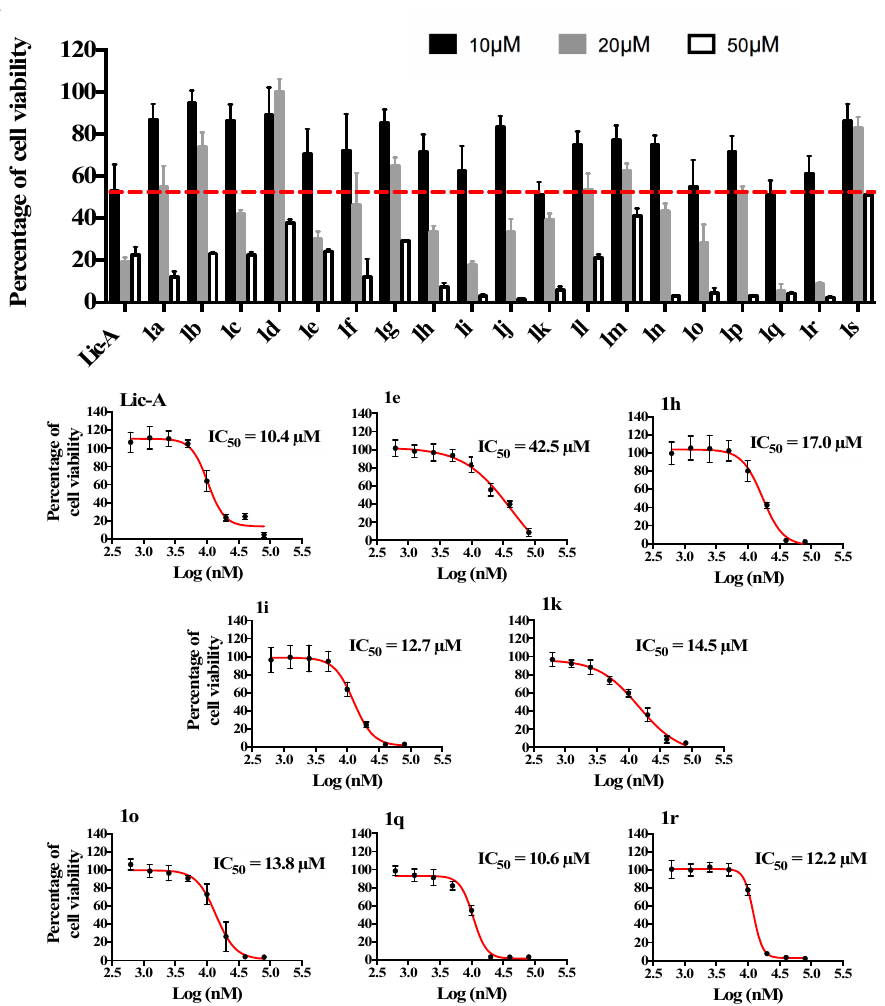
Figure 3. Effects of chalcones on MG63 cell viability by MTT assay 48 h after treatment . ( a ) Cells were incubated with 10, 20, and 50 µM of each compound; viable cells are expressed as percentage with respect to the control. ( b ) Dose–response curves and IC 50 calculation. Cells were incubated with 80, 40, 20, 10, 5, 2.5, 1.25, and 0.625 µM of Lic-A or the selected compounds.